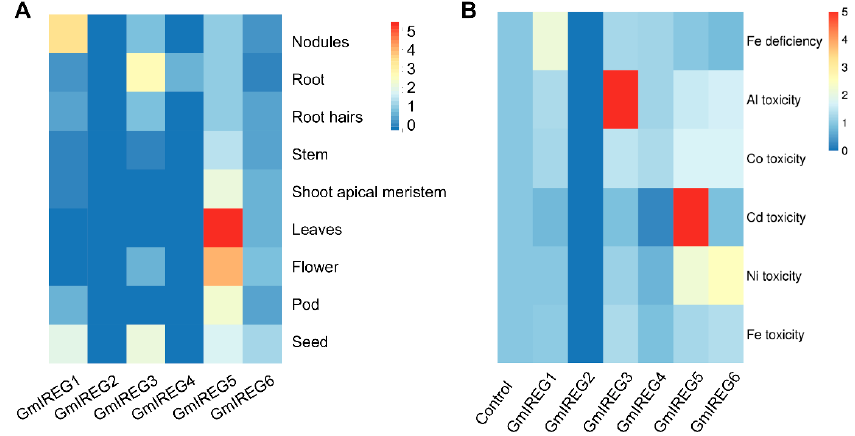
Figure 2. Tissue-specific expression and metal-induced expression patterns of six soybean IREG genes. ( A ) Heat map analysis shows the different tissue specific expression pattern of GmIREGs using the PKFM data of phytozome v12 database. ( B ) Expression of GmIREGs in response to Fe deficiency, Al toxicity, Co toxicity, Cd toxicity, Ni toxicity, and Fe toxicity. For Fe deficiency, uniform seedlings were exposed to normal conditions (half-strength nutrient solution, pH 5.6) or low-iron conditions